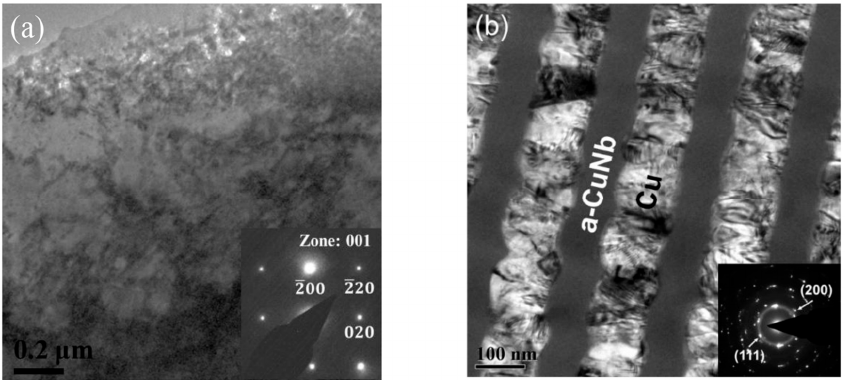
Figure 5. ( a ) Cross-section TEM micrograph of sputter-deposited nanocrystalline Cu film. ( b ) Cross-sectional TEM micrograph of sputter-deposited Cu 100 nm/a-CuNb 100 nm multilayer film.